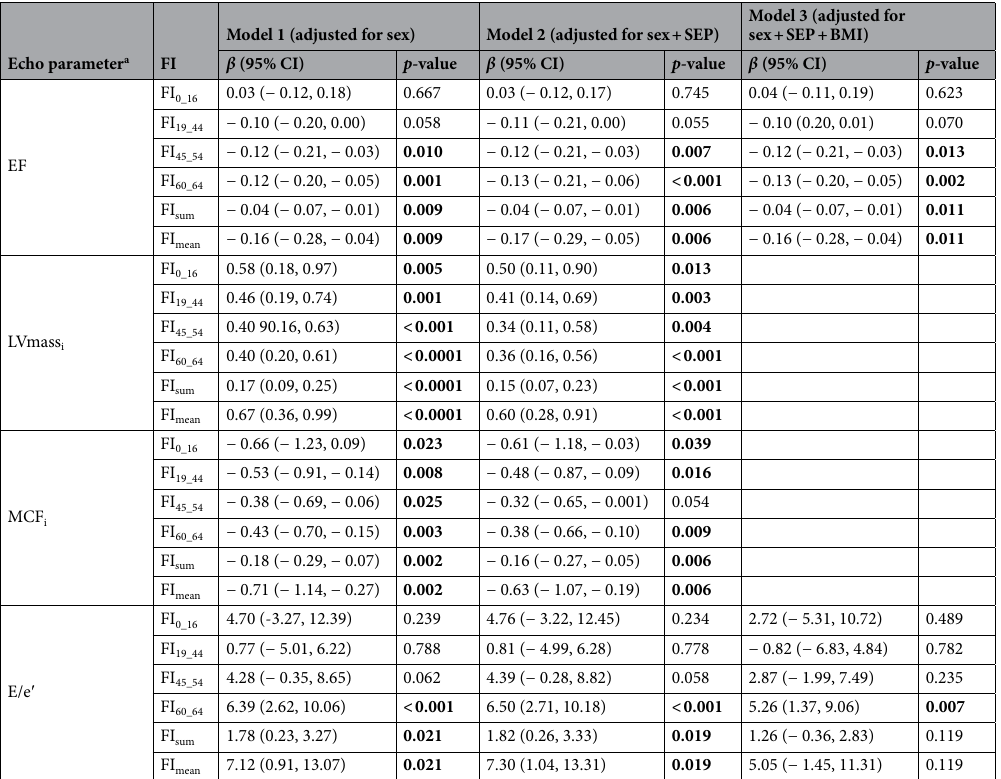
Table 2. Associations between health deficit burden at the 4 time periods and whole-of-life health deficit burden, with echocardiographic parameters (EF, LVmass i , MCF i and E/e ′ ) at 60–64 years. β regression coefficient, CI confidence interval. Other abbreviations as in Table 1. a All reported analyses here consisted of generalized linear models with gamma Distribution and log link except for E/e ′ that used logistic regression. Significant p -values are highlighted in